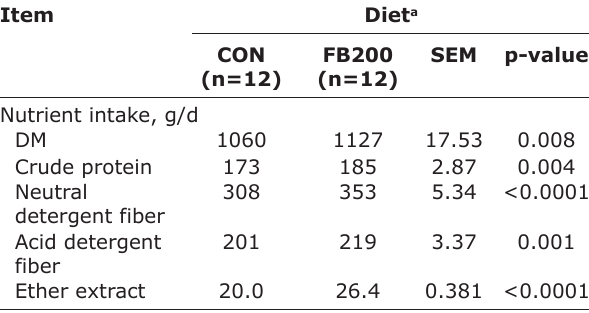
Table-2: Nutrient intake of Awassi lambs fed diets containing FB. Item